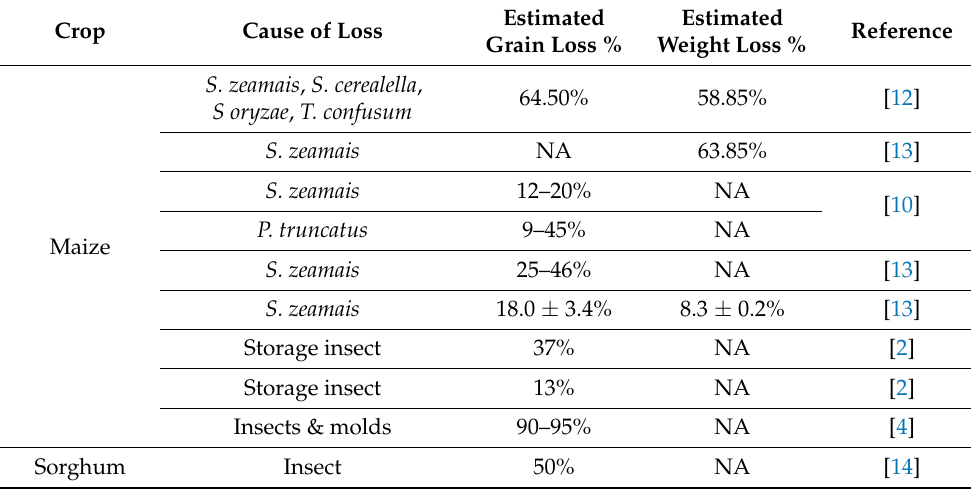
Table 1. A comparison of storage losses and pests of Ethiopia’s main food and export